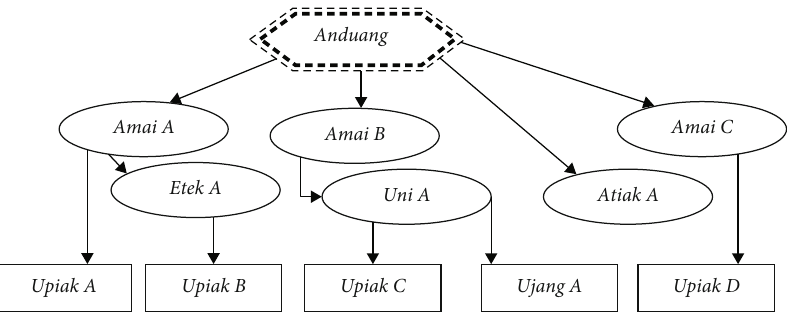
Figure 4: The structure of the four layers of traditional market traders in Pasa Table 6: Situational deixes from traders to women buyers Pasa Bawah Bukittinggi.